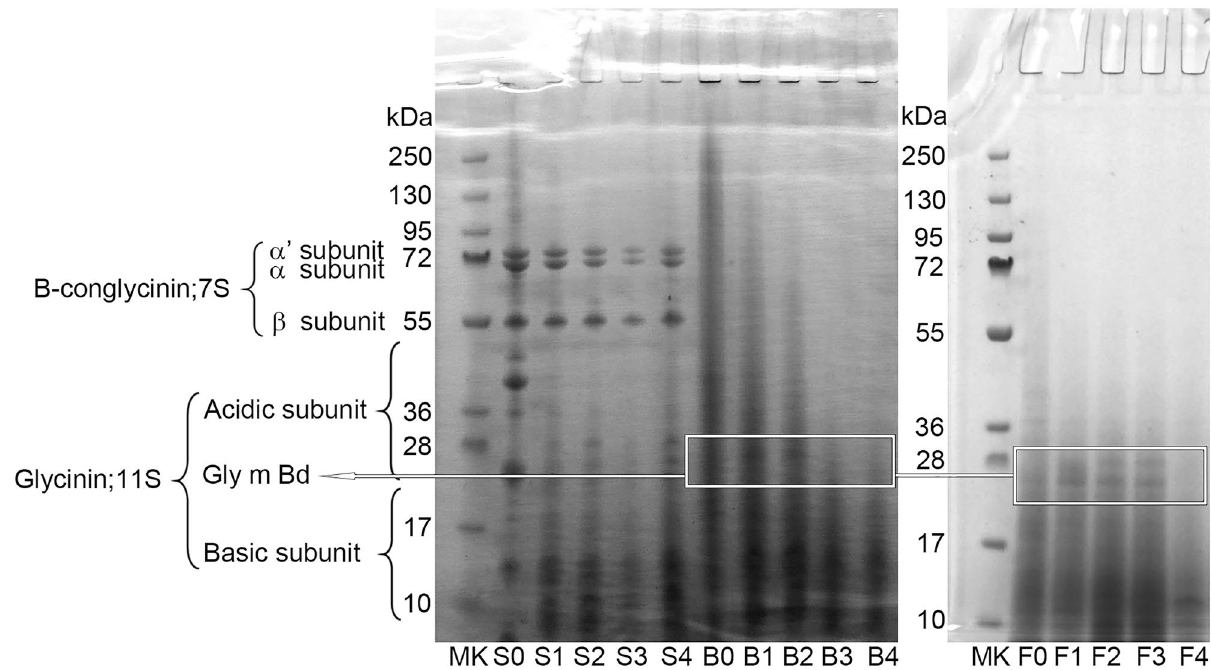
Figure 2. Changes in SDS-PAGE electrophoretogram for soaked (S), boiled (B), and fermented (F) soybean protein at each digestion stage. Lanes 1 and 12 represent a standard molecular marker (MK); lanes 2–6 present soaked bean before digestion (S0), gastric digestion 1 h (S1), gastric digestion 2 h (S2), intestinal digestion 1 h after gastric digestion (S3) and intestinal digestion 2 h after gastric digestion (S4), respectively; lanes 7–11 are for boiled bean in the same simulated digestion (B0–B4); lanes 13–17 are for fermented bean in the same simulated digestion